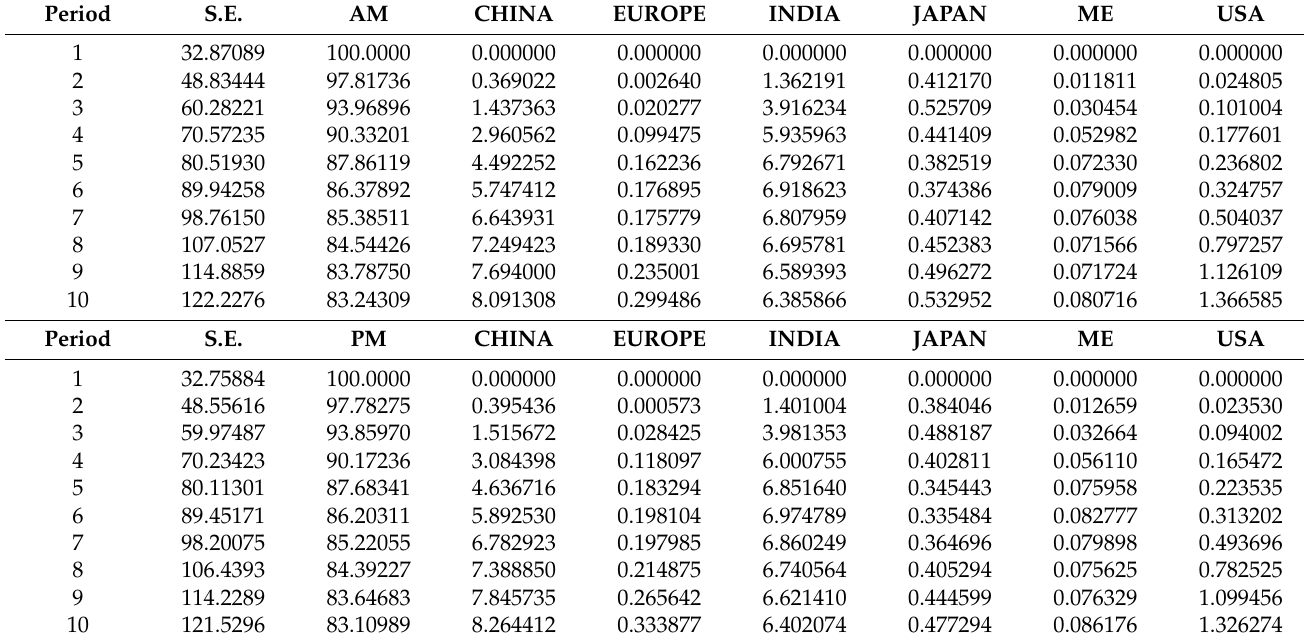
Table 6. The proportion of variances transmitted to AM and PM fix